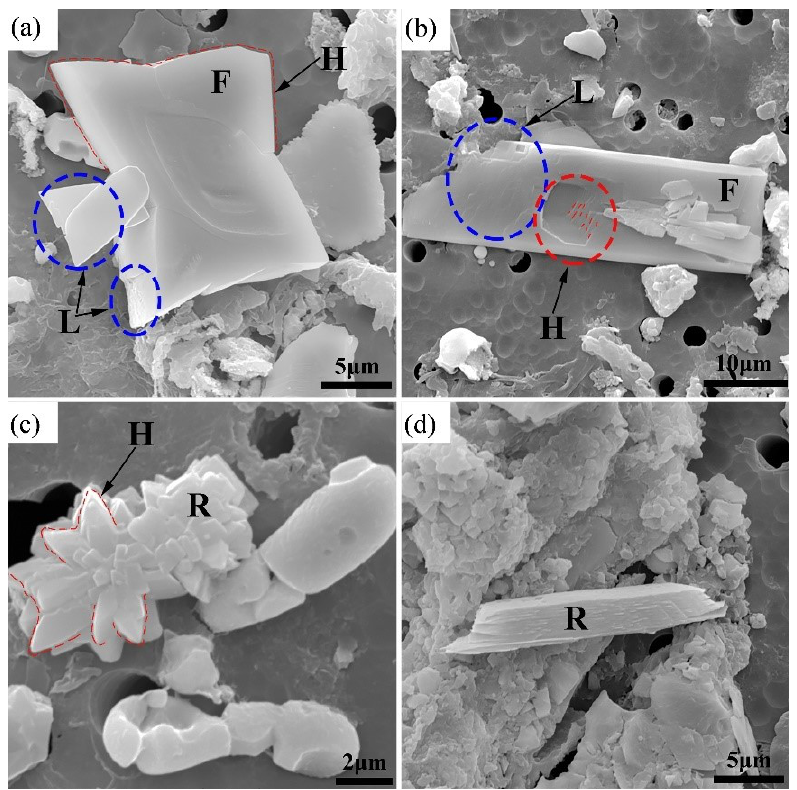
Figure 13. The morphologies of CaS inclusion at S content of 0.007%. F: flat interface; H: hopper morphology; L: layer growth; R: rough interface. (a) and (b) . Hopper morphology CaS with flat interface. (c) and (d) layer growth CaS with rough interface.